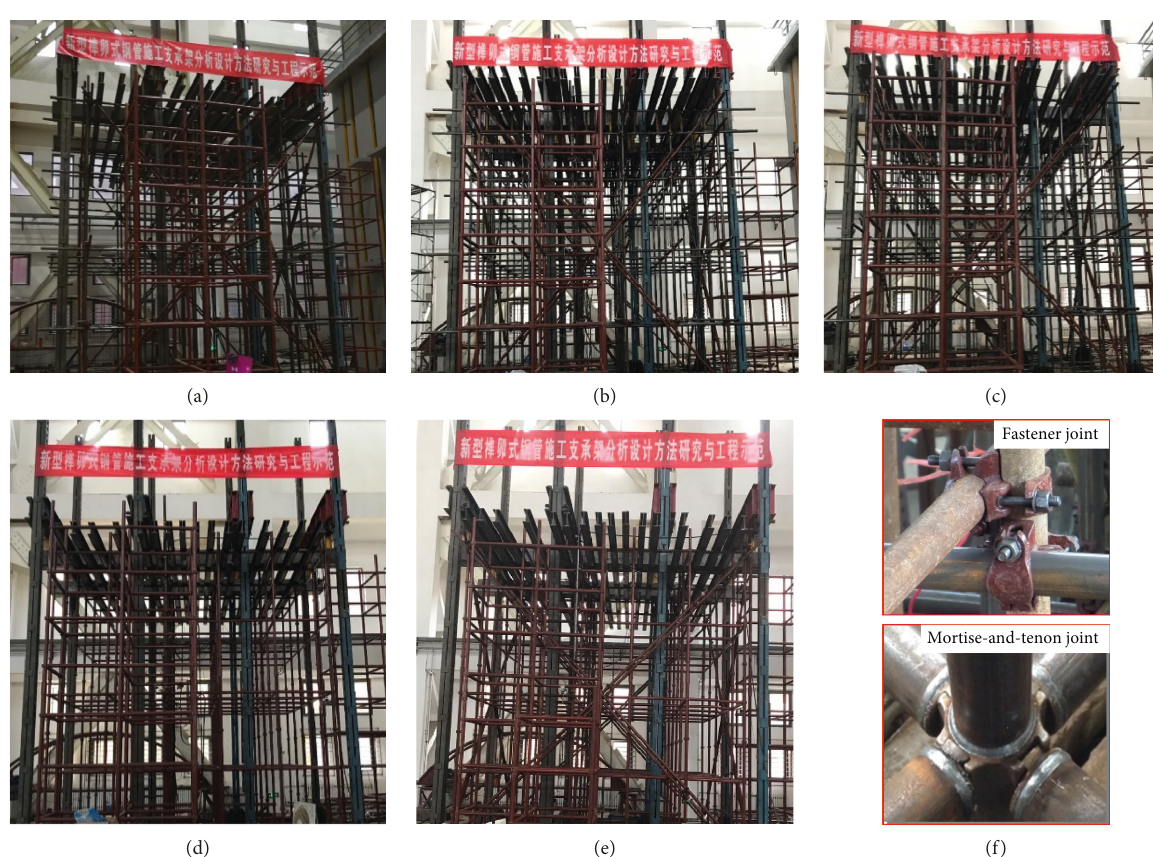
Figure 2: Overallstructuresofexperimentalmodels.(a)Fastenerscaffold.(b)Fastenerscaffoldreinforcedwithtruss.(c)Fastenerscaffoldreinforced with weak truss. (d) Mortise-and-tenon scaffold without diagonal bracing. (e) Mortise-and-tenon scaffold with diagonal bracing. (f) Types of